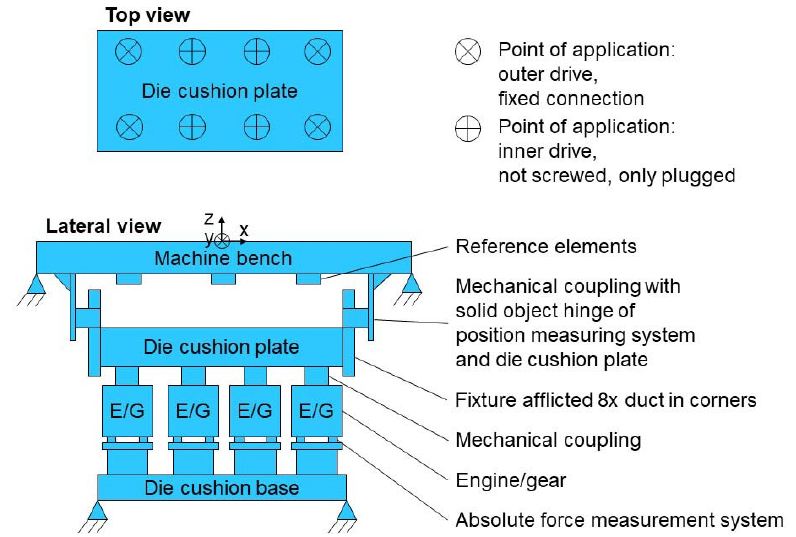
Figure 1. Structure of the electromechanical multipoint die cushion cf. [11].